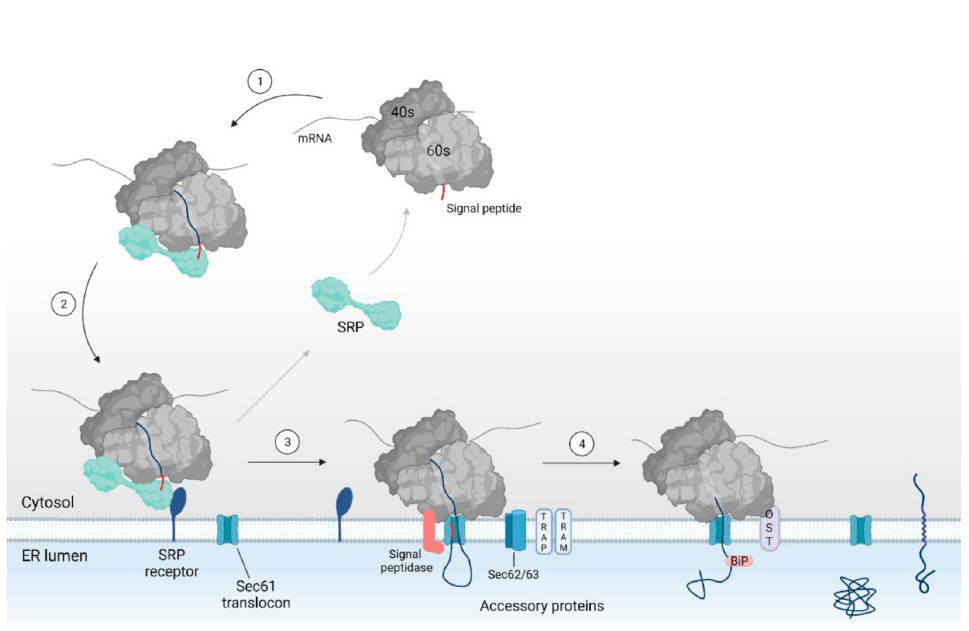
Figure 2. Overview of the SRP dependent pathway for co-translational translocation via the Sec61 translocon. A secretory or integral membrane protein is targeted toward the ER membrane by means of SRP binding to the signal sequence (i.e., the SP or TMD (steps 1–2)). SRP binding stalls protein translation to keep the nascent chain in a translocation competent state. At the ER membrane, SRP interacts with the SRP receptor. The RNC complex is then transferred to the Sec61 translocon (step 3). Interaction of the ribosome with the translocon reinitiates translation and induces conformational changes within Sec61 α , eventually leading to protein translocation. In the case of a weak hydrophobic SP or TMD, the protein requires help from accessory proteins such as TRAP, TRAM, Sec62, and/or Sec63 for protein translocation. In the ER lumen, the SP is cleaved by the signal peptidase complex and the protein is glycosylated by the OST complex (step 4). SRP: signal recognition particle, ER: endo- plasmic reticulum, SP: signal peptide, TMD: transmembrane domain, RNC: ribosomal nascent chain, TRAP: translocon-associated protein, TRAM: translocating chain-associating membrane protein, OST: oligosaccharyl